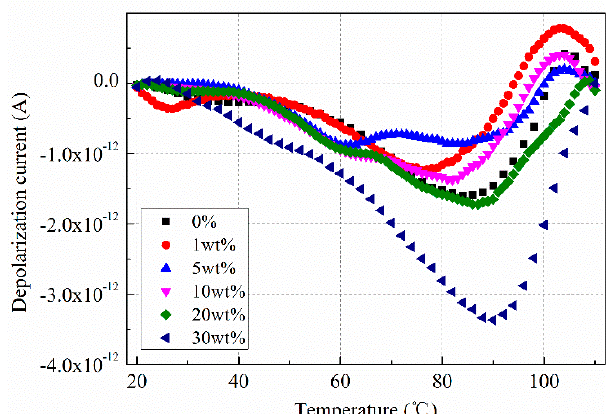
Figure 9. Depolarization current in insulation sample under semi-conductive composites with different SrFe 12 O 19 contents.